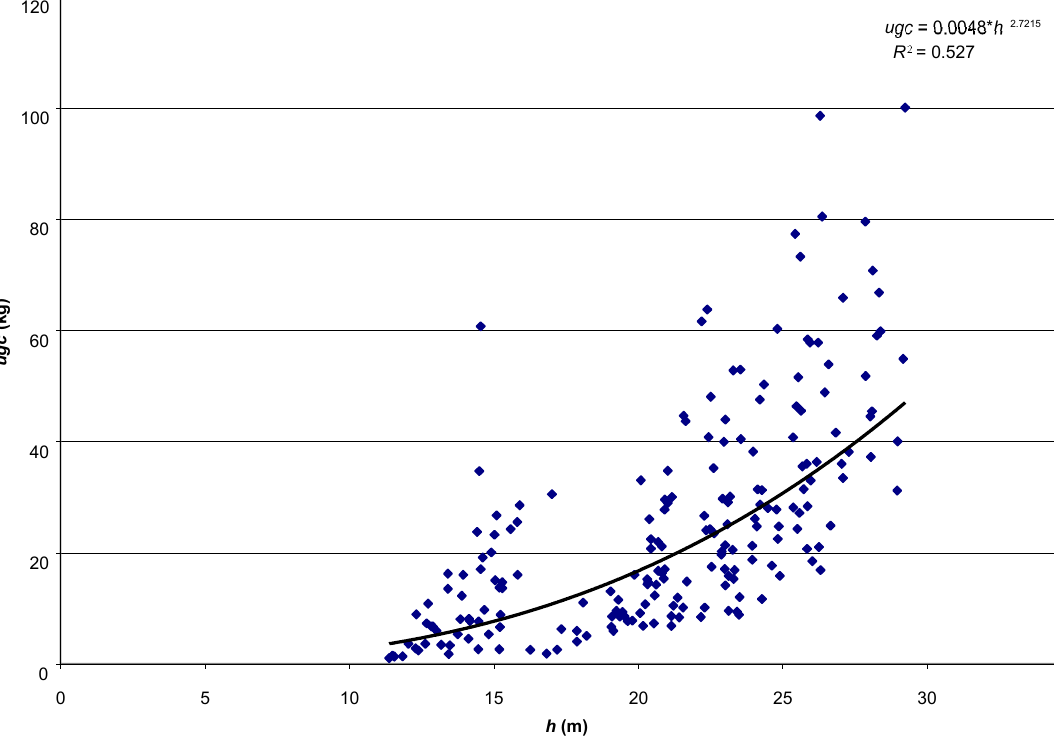
Figure 2. Dependence of weight of leaved twigs ( ugc ) on height ( h ).